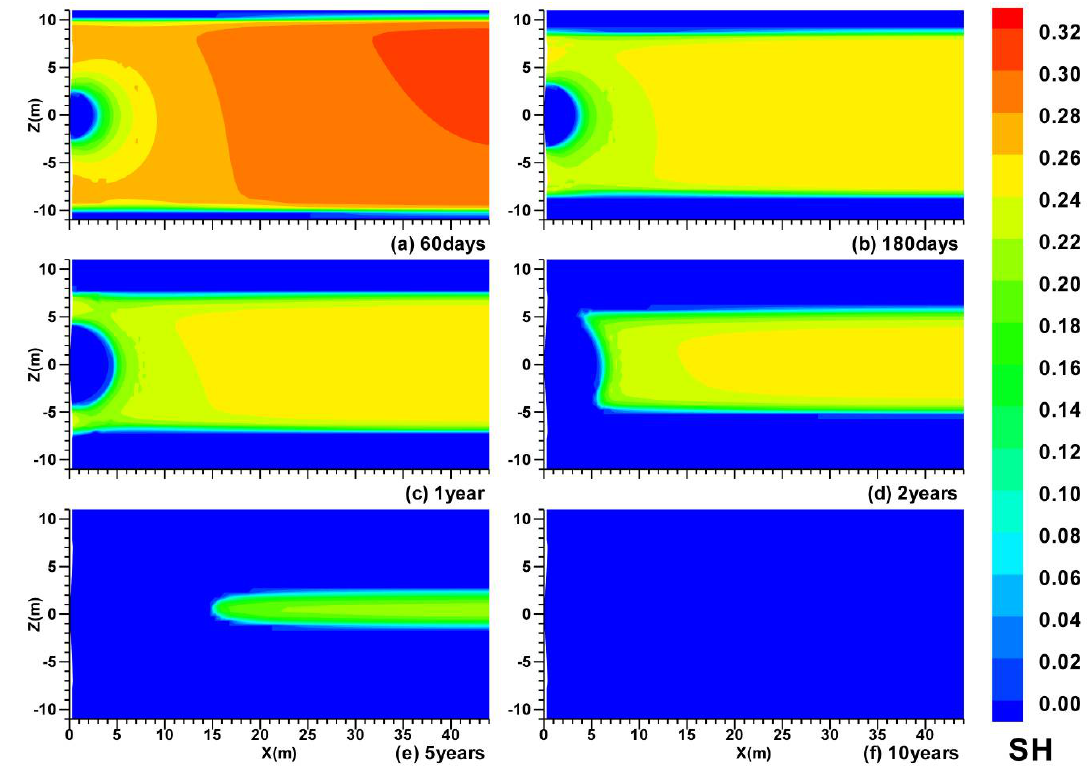
Figure 9. Evolution of spatial distribution of S UB) in Case